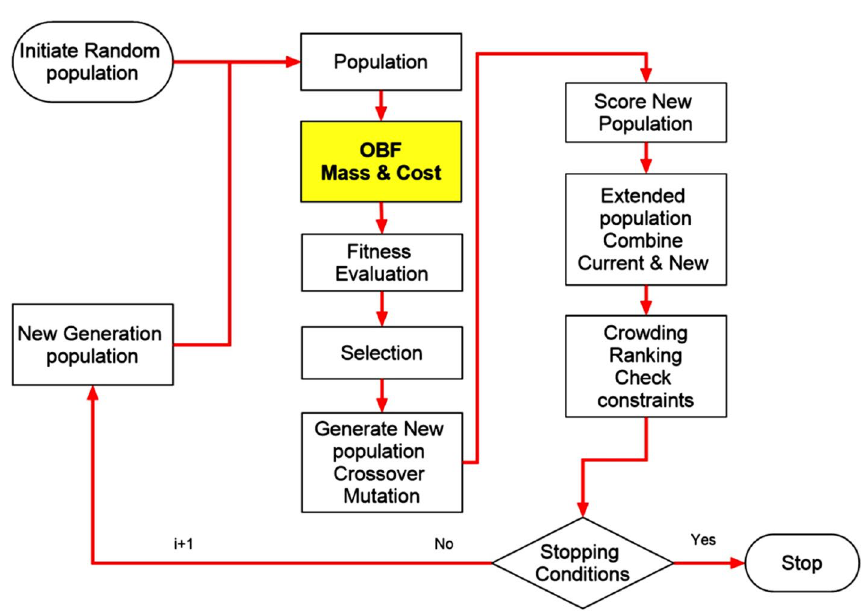
Fig. 4 Flowchart for the multi-objective optimization model in the study using elite genetic